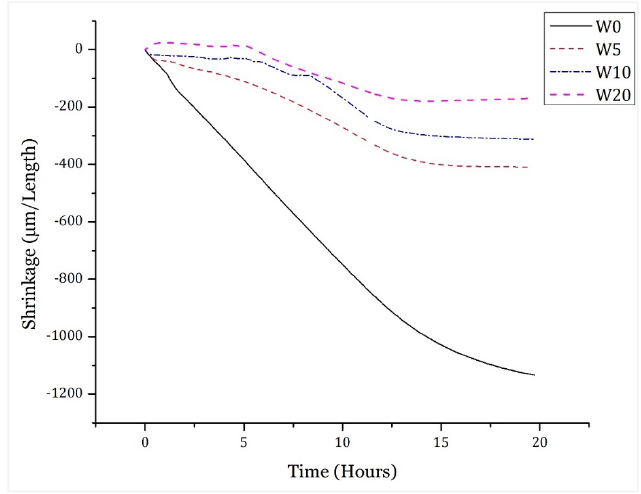
Figure 6. Linear shrinkage response of WSA-incorporated concrete.